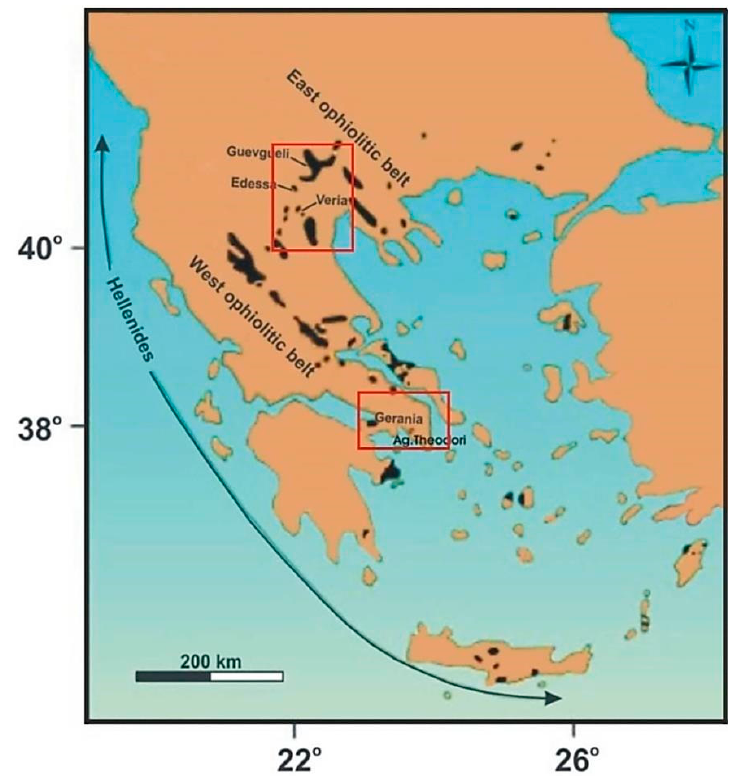
Figure 1. Simplified map showing the sampling areas in the red rectangles.